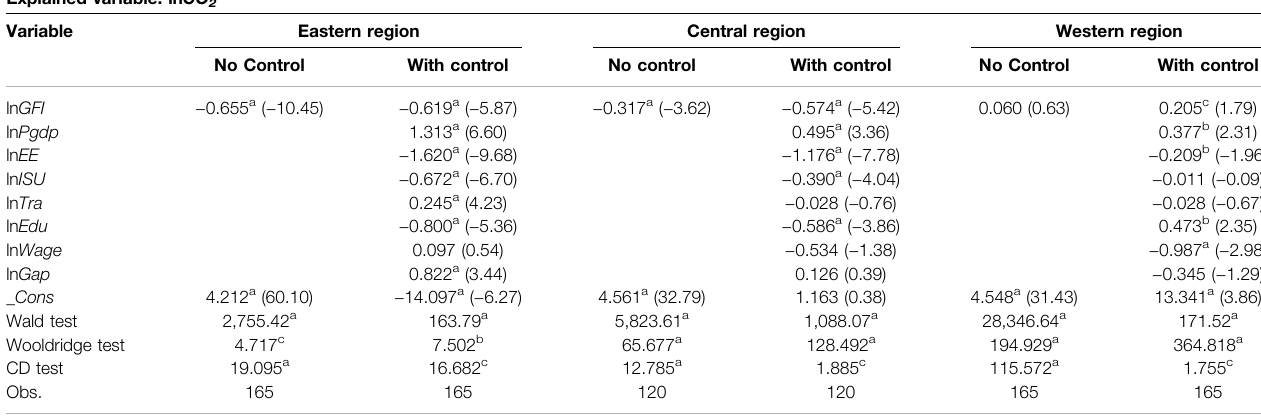
TABLE 5 | Estimated results of geographic heterogeneous analysis. Explained variable: ln CO